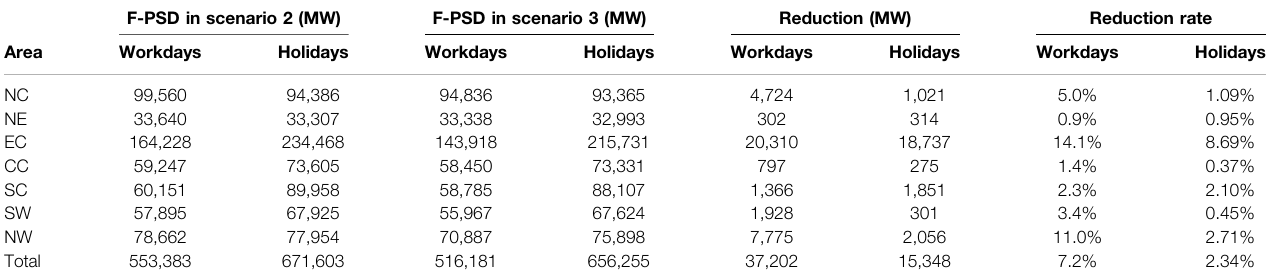
TABLE 4 | Final peak shaving demand (F-PSD) in various areas in China. F-PSD in scenario 2